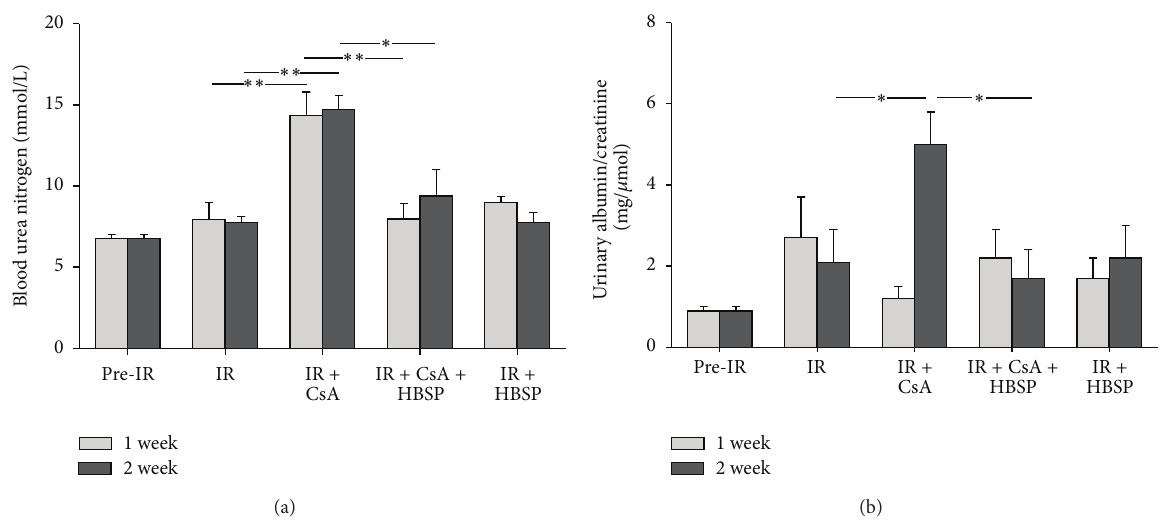
Figure 1: The level of BUN was decreased by HBSP treatment in the IR kidneys exposed to CsA at both 1 and 2 weeks (a). The ratio of urinary albumin/creatinine was significantly increased by CsA in the kidneys subjected to IR injury but decreased by HBSP treatment only at 2 weeks (b). Data are expressed as mean value of each group (mean ± SEM; 𝑛 = 6 ). ∗ 𝑃 < 0.05 ; ∗∗ 𝑃 < 0.01